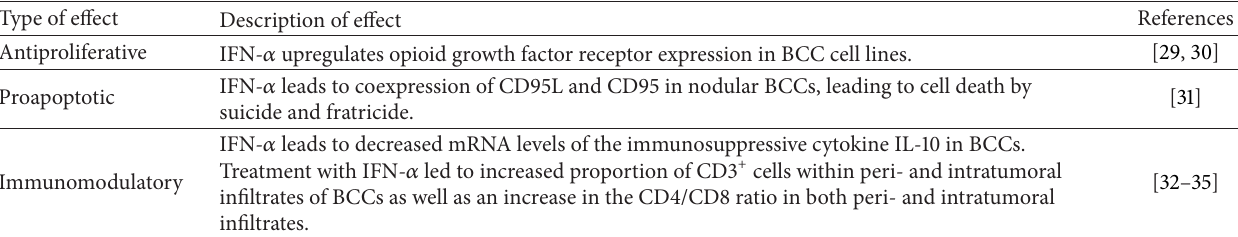
Table 3: Effect of type I interferon on basal cell